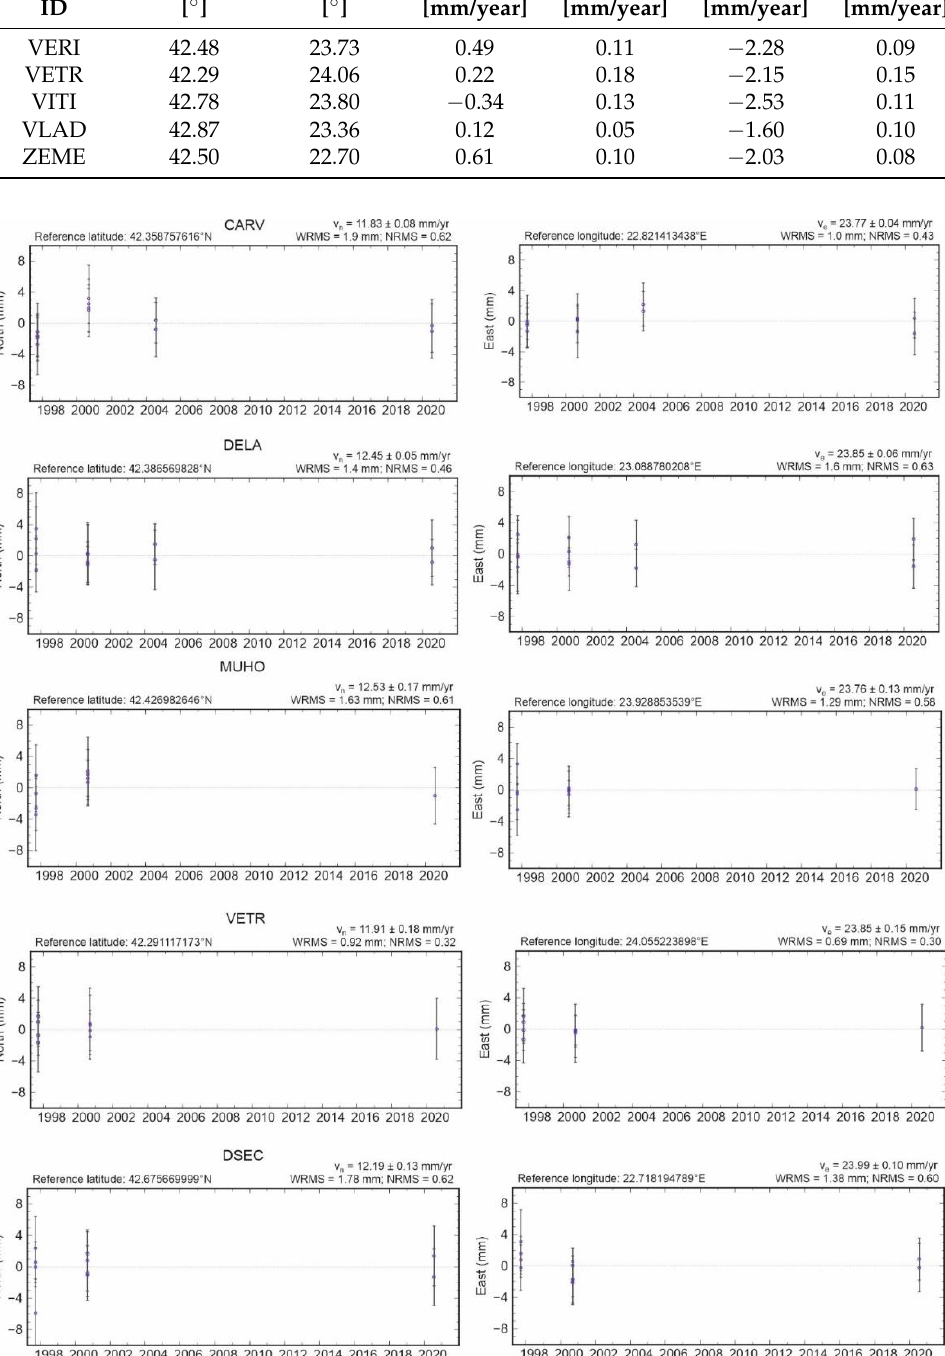
Figure 2. Long-term repeatability of the horizontal station positions. All obtained horizontal velocities clearly exceed 1.5 – 2 mm/y, reaching up to 3 – 4 mm/y. As a general tendency, the velocities tend to increase from north to south. The northernmost area (N – NW of Sofia) sees a majority of velocities of about 1.5 mm (stations BERK, VLAD, BUHO, and SLIV). In the area to the south of Sofia, velocities of 2 – 3 mm/y (stations DSEC, CARV, BOGO, VERI, PADA, VETR, and MALA) dominate. Further south, the velocities of DOB1 and SATO are almost 4 mm/y, which is the highest in the area. The behavior of some stations with velocities from earlier campaigns [6] (e.g., VLAD and